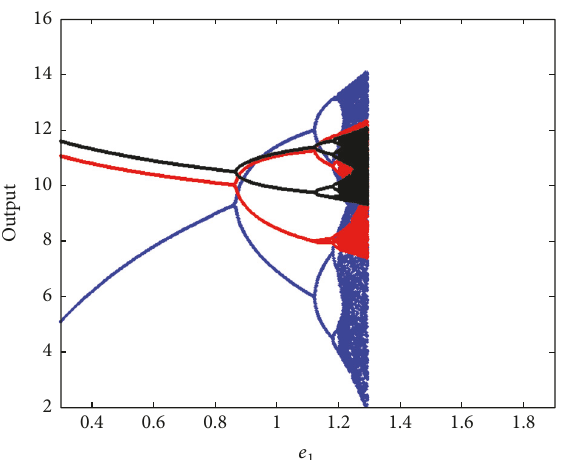
Figure 15: Bifurcation diagram with 𝑒 1 , 𝛼 = 0.3 , 𝛽 = 0.2 , and 𝛾 = 0.1